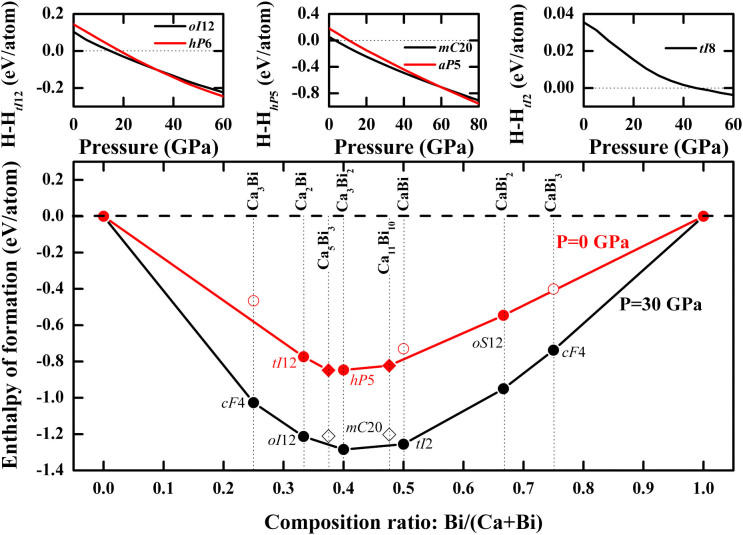
Enthalpy differences (top) and convex hull for the Ca-Bi system (bottom).Calculated enthalpy differences as a function of pressure relative to tI12 of Ca2Bi (top left), hP5 of Ca3Bi2 (top middle) and tI2 of CaBi (top right) and convex hull (bottom) for the Ca-Bi system at ambient pressure(red) and 30 GPa (black).